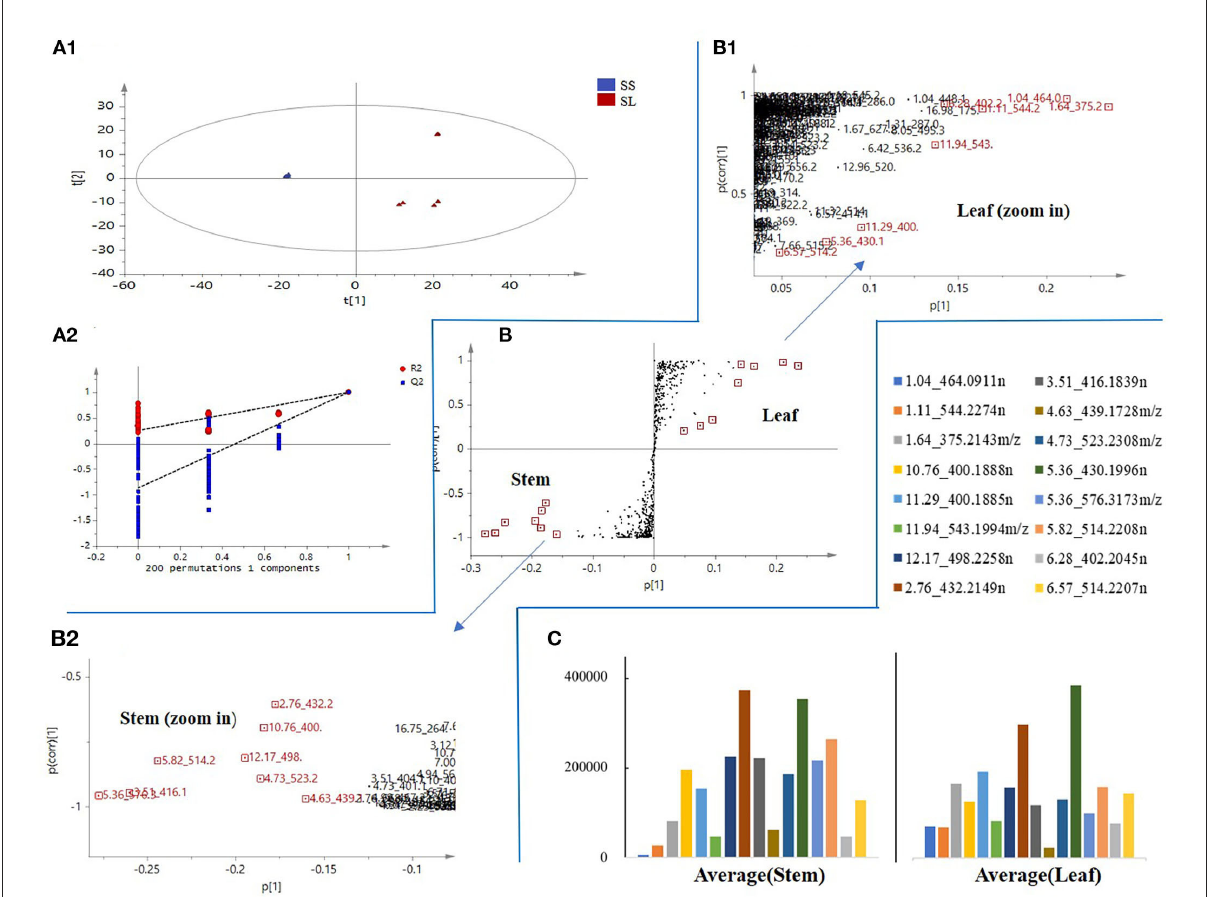
FIGURE5 An example of marker compound selection in S. chinensis . (A) orthogonal partial least-squares discriminant analysis (OPLS-DA) score plot and the reliability of the OPLS-DA model. (B) S-plot score of SS and SL. (C) The trend of the relative contents of different compounds in SS and